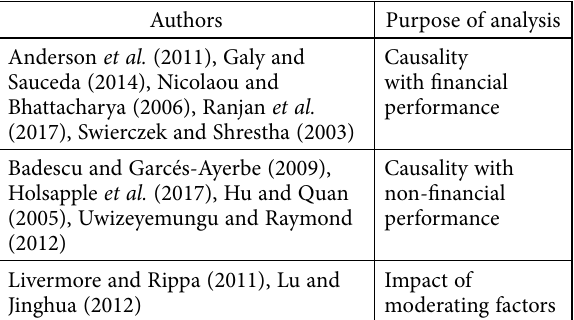
Table 2. Previous studies related to causality analysis Authors